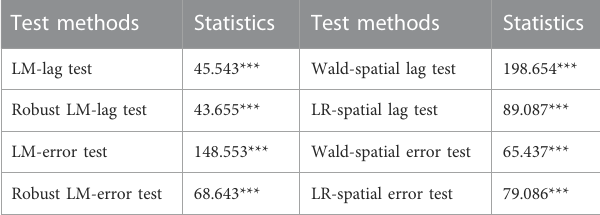
TABLE 7 Test results of spatial